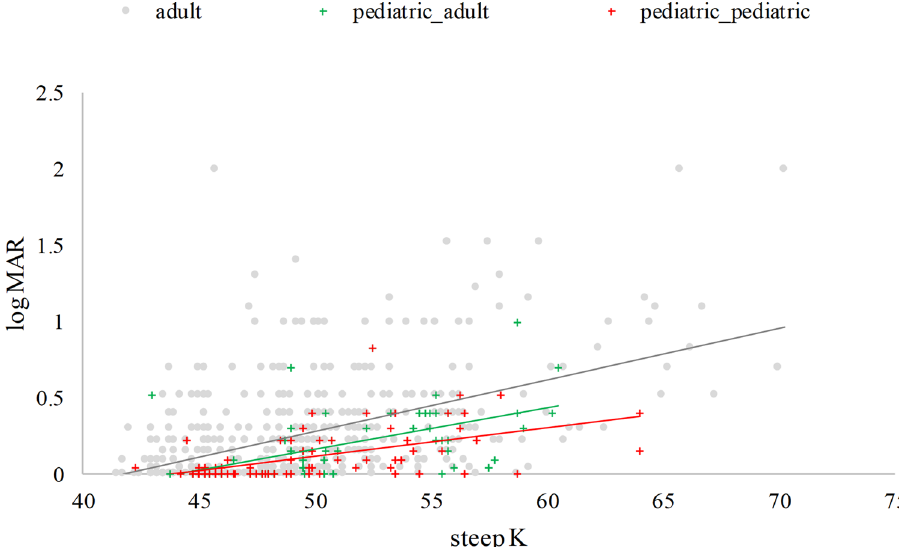
Figure 3. CDVA vs. steep K for the three groups: adult, pediatric_pediatric (the first diagnosis of KC below 18 years old and taking the measurements at age ≤ 18 years old), pediatric_adult (the first diagnosis of KC below 18 years old but taking the measurements at age > 18 years old) (r =